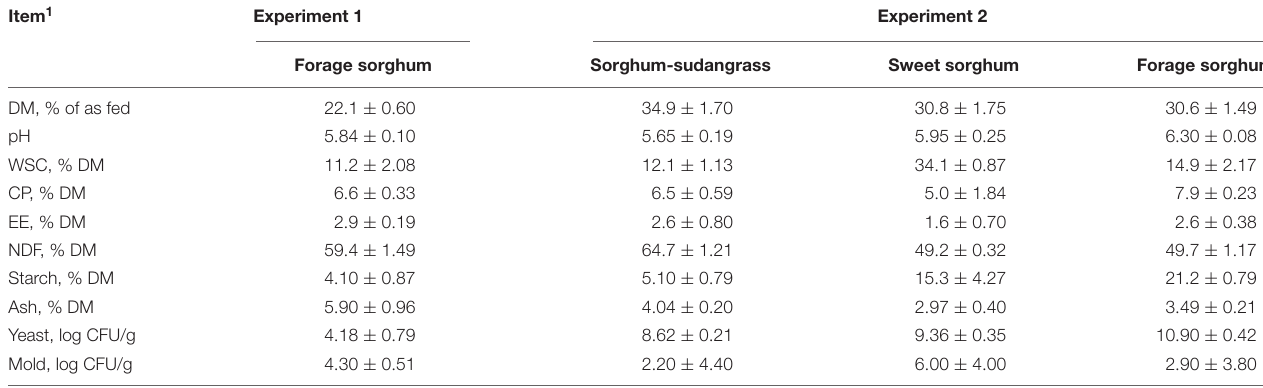
TABLE 1 | Nutrient composition, pH, and yeast and mold counts of fresh, uninoculated whole-plant sorghum forage in experiments 1 and 2. Item 1